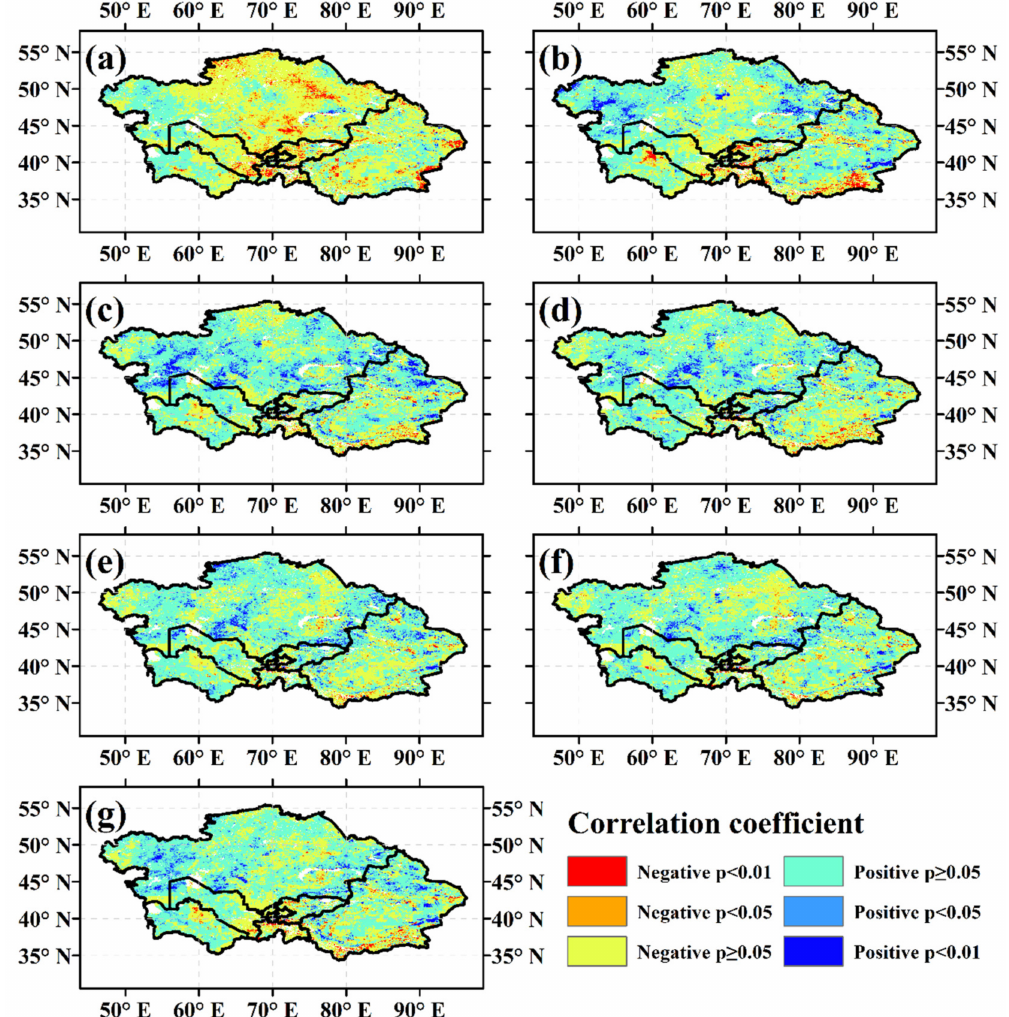
Figure 7. Correlation coefficient between winter snowfall and NDVI in April ( a ), May ( b ), June ( c ), July ( d ), August ( e ), September ( f ), and growing season ( g